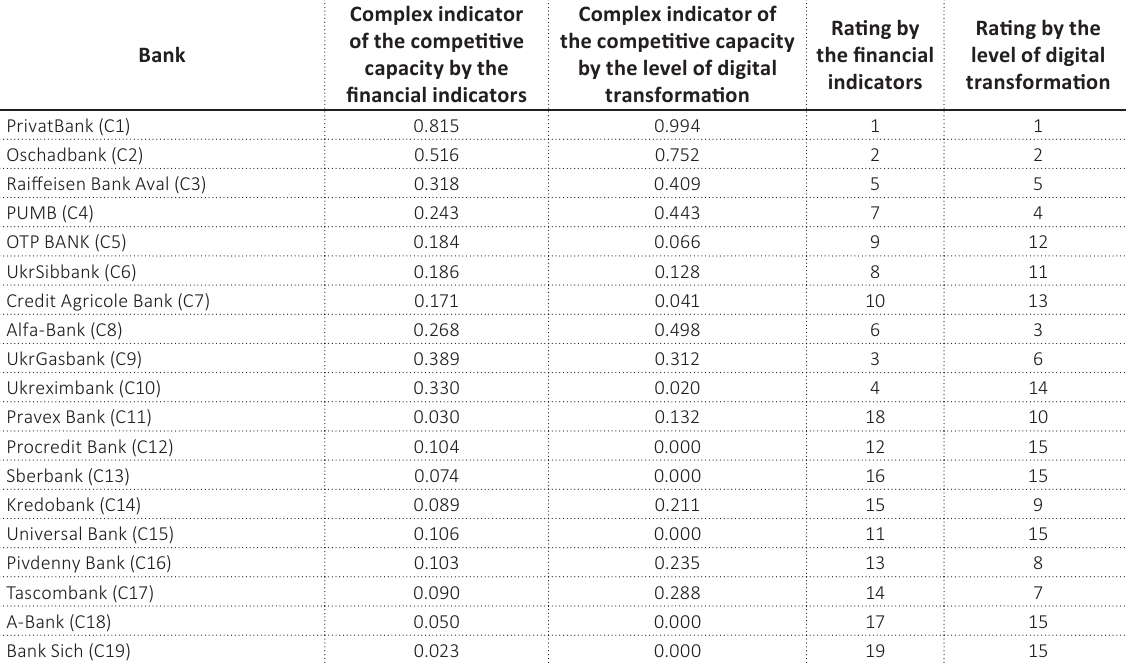
Table 3. Assessment of the competitive capacity of Ukrainian